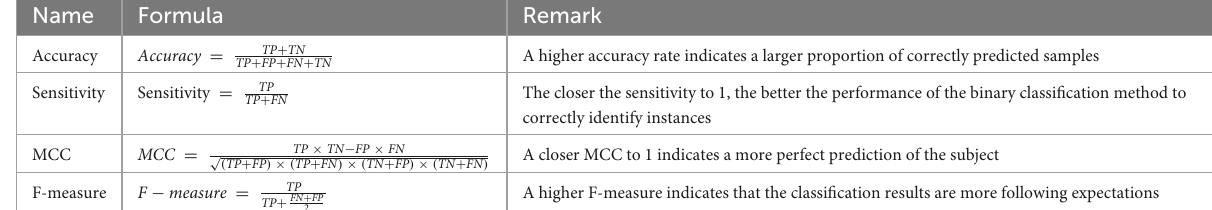
TABLE 12 Detailed description of the evaluation criteria.